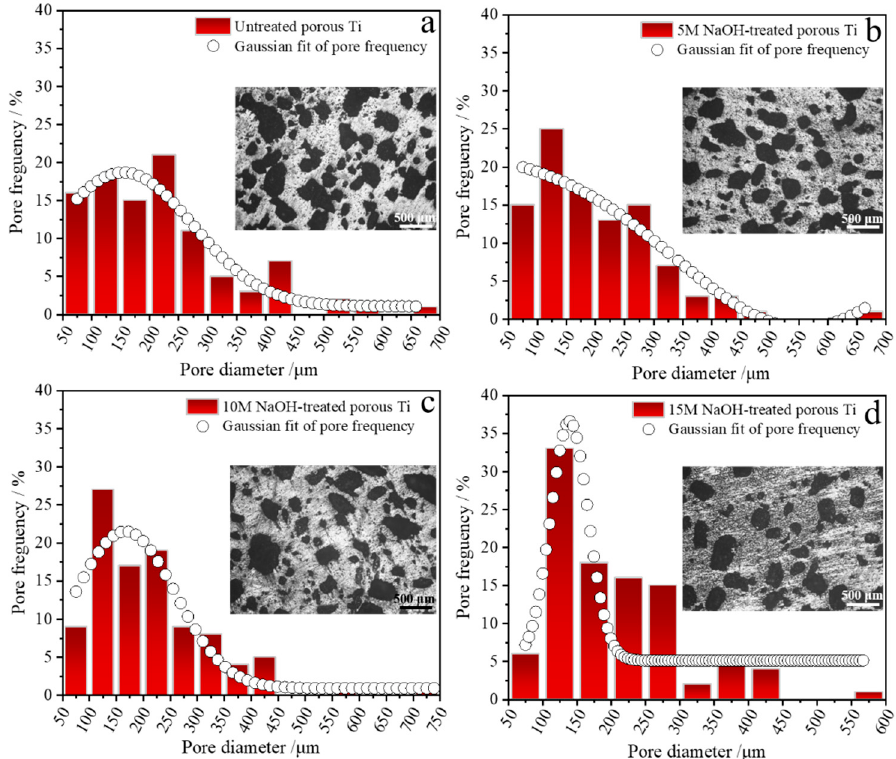
Figure 2. Optical microscopic morphology and aperture size frequency distribution of porous Ti after being treated with different concentrations of NaOH. ( a ) Untreated porous Ti. ( b ) 5 M NaOH-treated porous Ti. ( c ) 10 M NaOH-treated porous Ti. ( d ) 15 M NaOH-treated porous Ti.